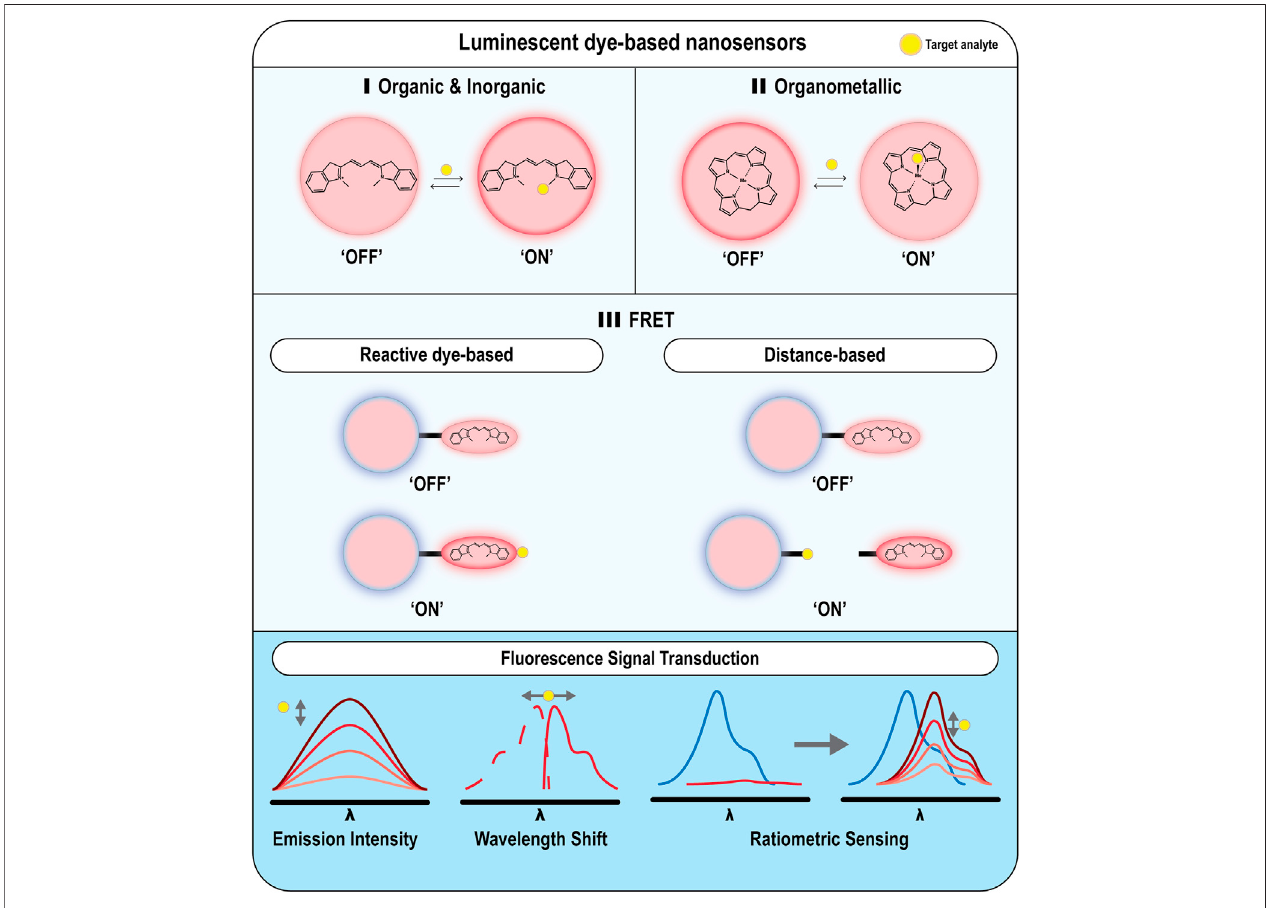
FIGURE 3 | Examples of different nanoparticle-based optical techniques for monitoring oxygen and ROS. Nanoparticles can be either functionalized with (A) organic or inorganic dyes for monitoring ROS (B) organometallic dyes for monitoring O 2 levels, or (C) FRET pairs for monitoring ROS species.